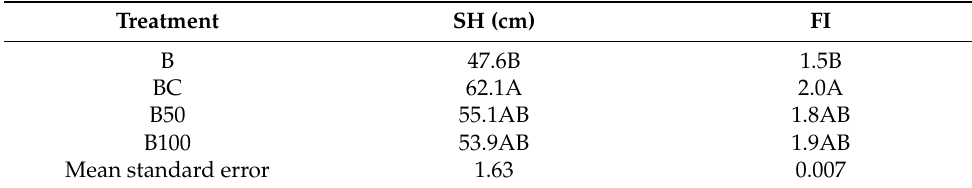
Table 2. Averages of sward heights (SHs) and falling indices (FIs) for the different treatments at the end of the deferral period.